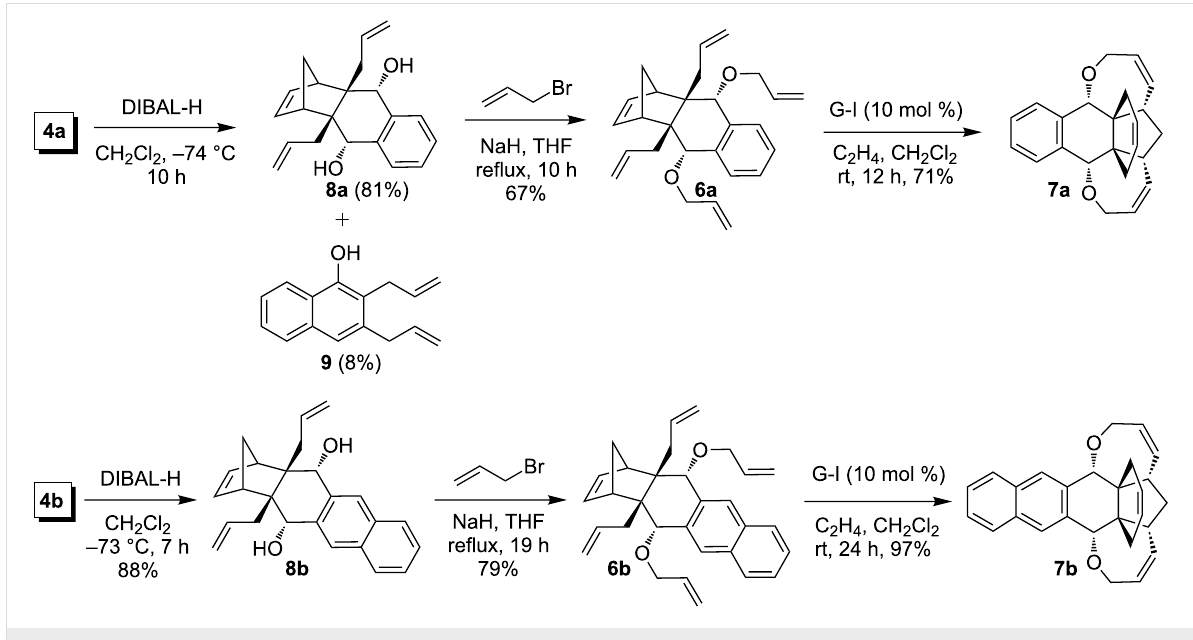
Scheme 4: Synthesis of the propellane/oxa-bowl hybrids 7a , b via RRM.